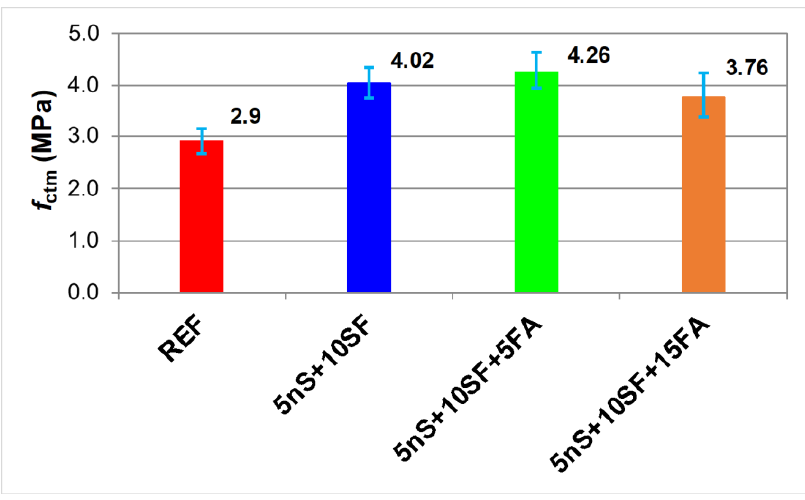
Figure 7. Results of splitting tensile strength of concretes. Table 3. Compressive strength and splitting tensile strength of concretes.